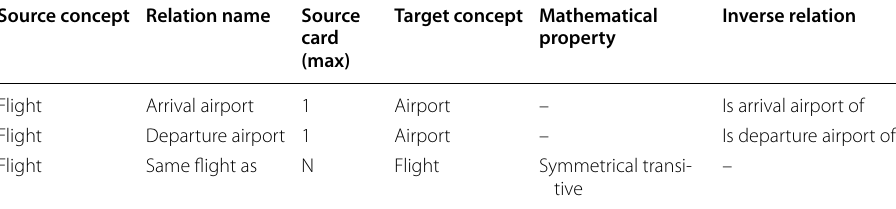
Table 4 Single-responsibility binary